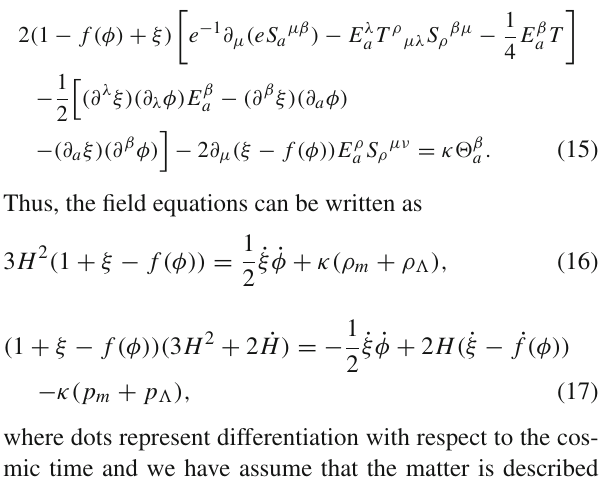
Fig. 1 Evolution of G [ T ] as a function of the cosmic time in Gyr for some values of